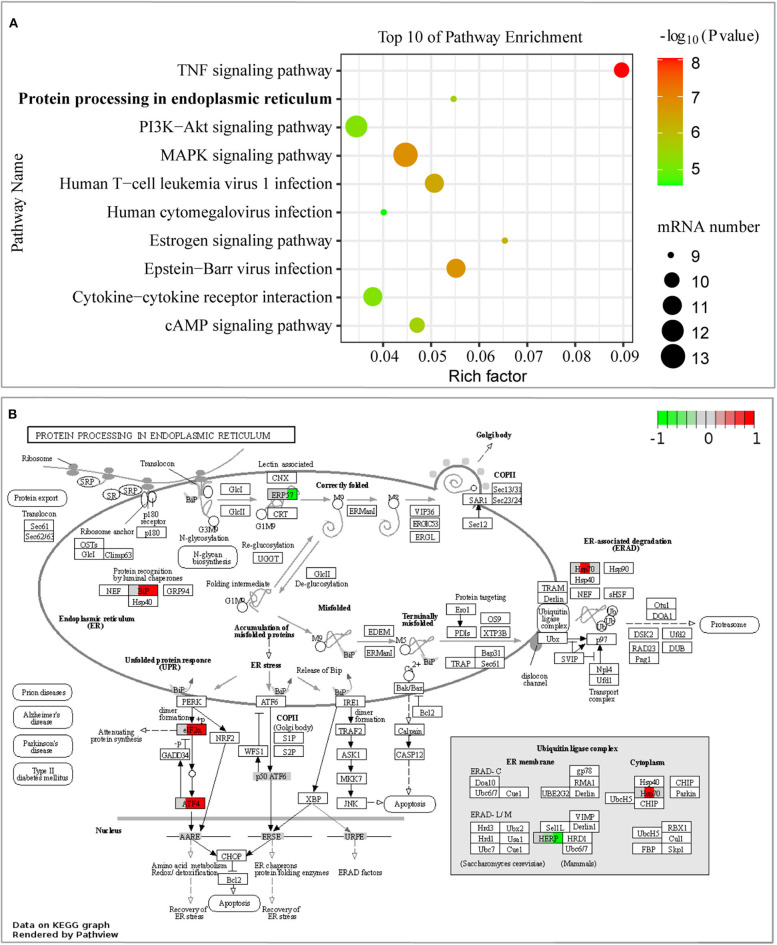
Pathway analysis of DEGs from GeneChip™ microarray assay. (A) The 10 most enriched KEGG pathways were displayed in scatter charts. Different colors indicate different P-value ranges. Important pathways were outlined in red bubbles. The different sizes of the dot indicate the number of target genes in the pathway. The pathway of protein processing in the endoplasmic reticulum was significantly enriched, P < 0.001. (B) Comparison of single gene expression changes in the pathway of protein processing in the endoplasmic reticulum. DEGs were colored in red (up-regulated) or green (down-regulated), and white or gray represents no significant difference in gene expression. Each colored box was divided into three parts, and the left, middle, and right parts represent the expression state of cells without infection, 6, and 12 hpi, respectively.